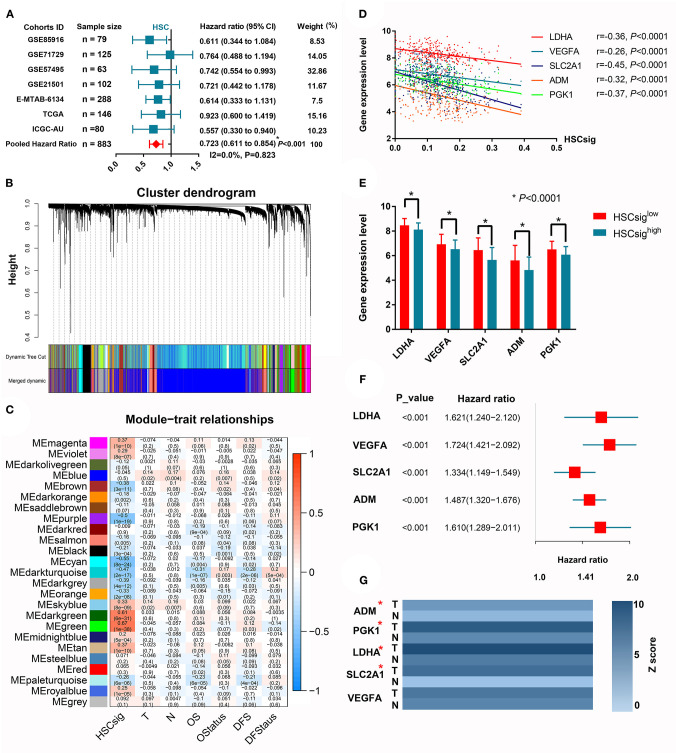
Increased hematopoietic stem cell-like signatures predict better prognoses in patients with PDAC. (A) A meta-analysis revealed that HSC-like signatures predict prolonged OS in PDAC patients. (B) WGCNA identified gene modules with high coexpression correlation. (C) The correlations between 25 coexpressed gene modules and HSC-like signatures and clinical characteristics. (D) The linear correlations between the expression of five core genes and HSC-like signatures. (E) Comparison of the expression levels between groups with high or low levels of HSC-like signatures. (F) The survival implications of five core genes in PDAC. (G) The differential expression of core genes between tumor and adjacent normal tissues. *P < 0.05.